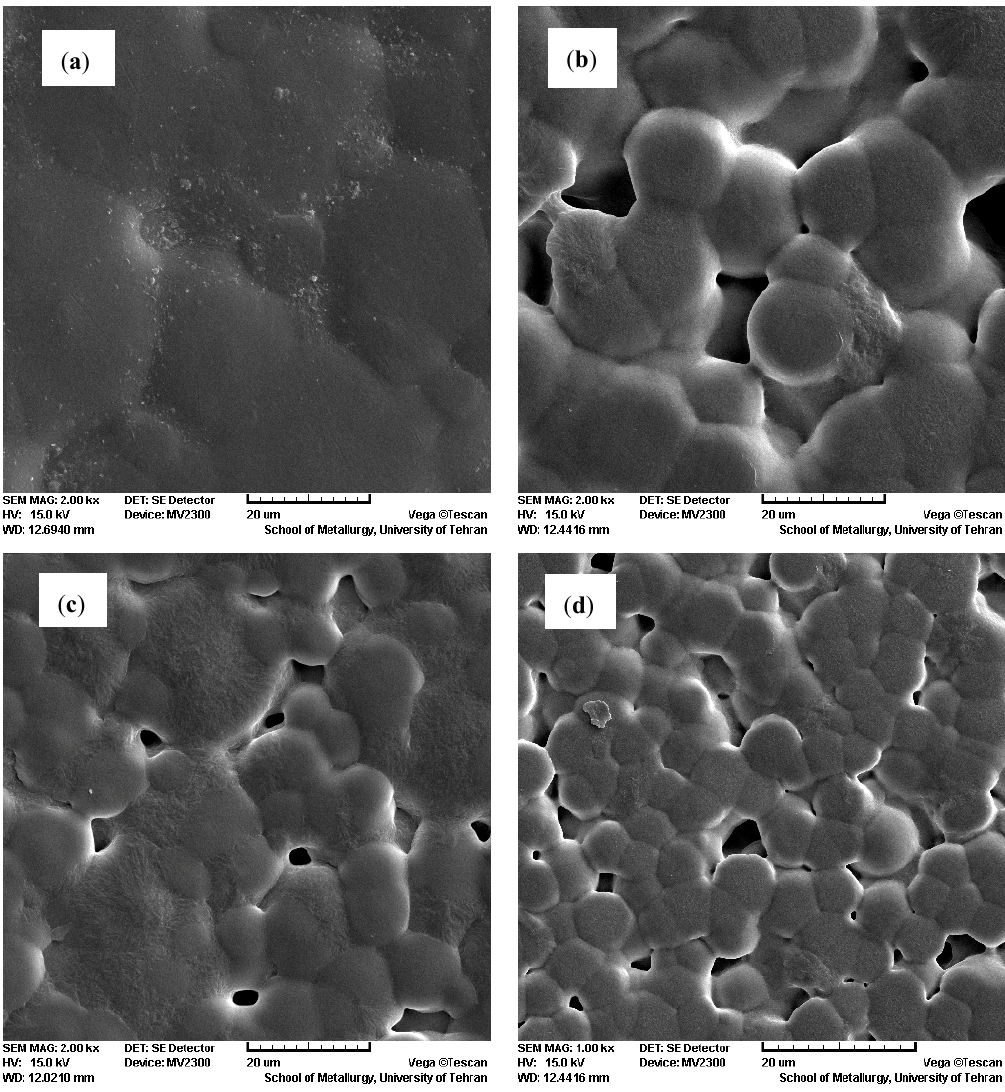
Figure 4. The SEM images of ( a ) PVDF, ( b ) PVDF/0.05%Au, ( c ) PVDF/0.1%Au and ( d ) PVDF/0.5%Au.